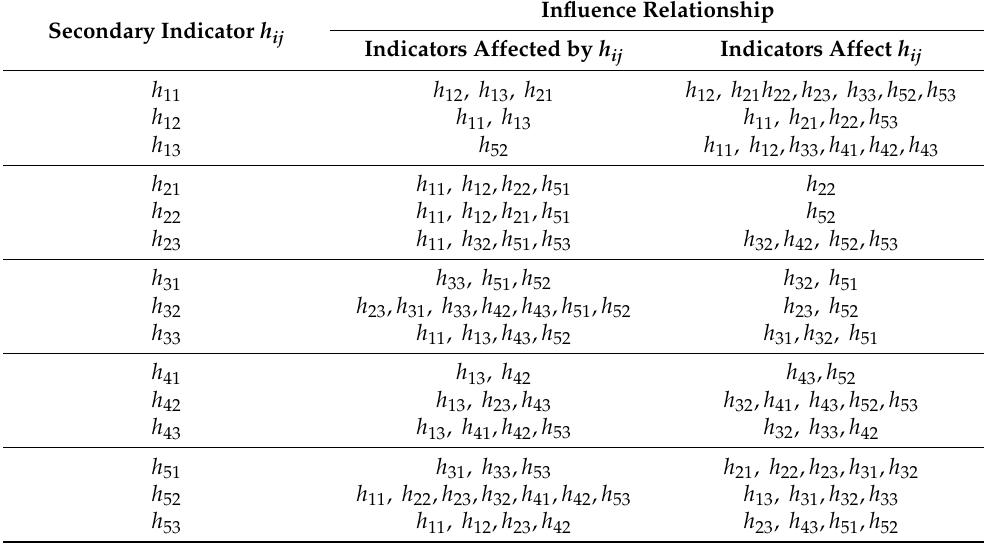
Table 2. Influence relationship among second-level indicators.